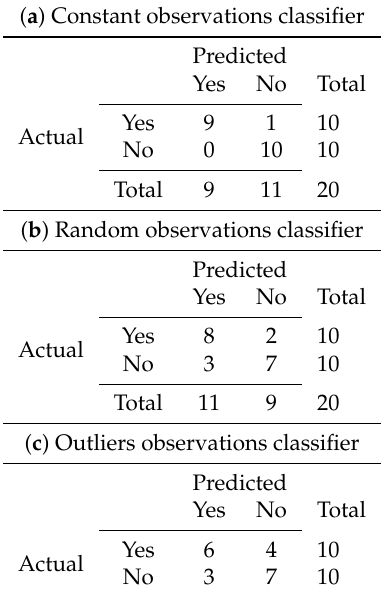
Table 1. Confusion matrices.